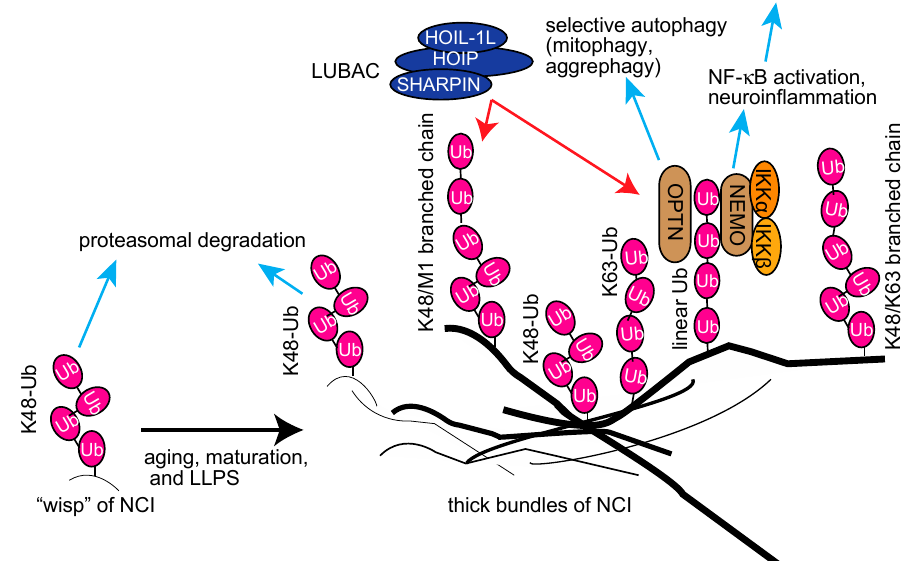
Figure 6. Proposed schema for the involvement of multiple ubiquitin chains, including linear ubiquitin, in neurodegenerative diseases, and their potential functions.